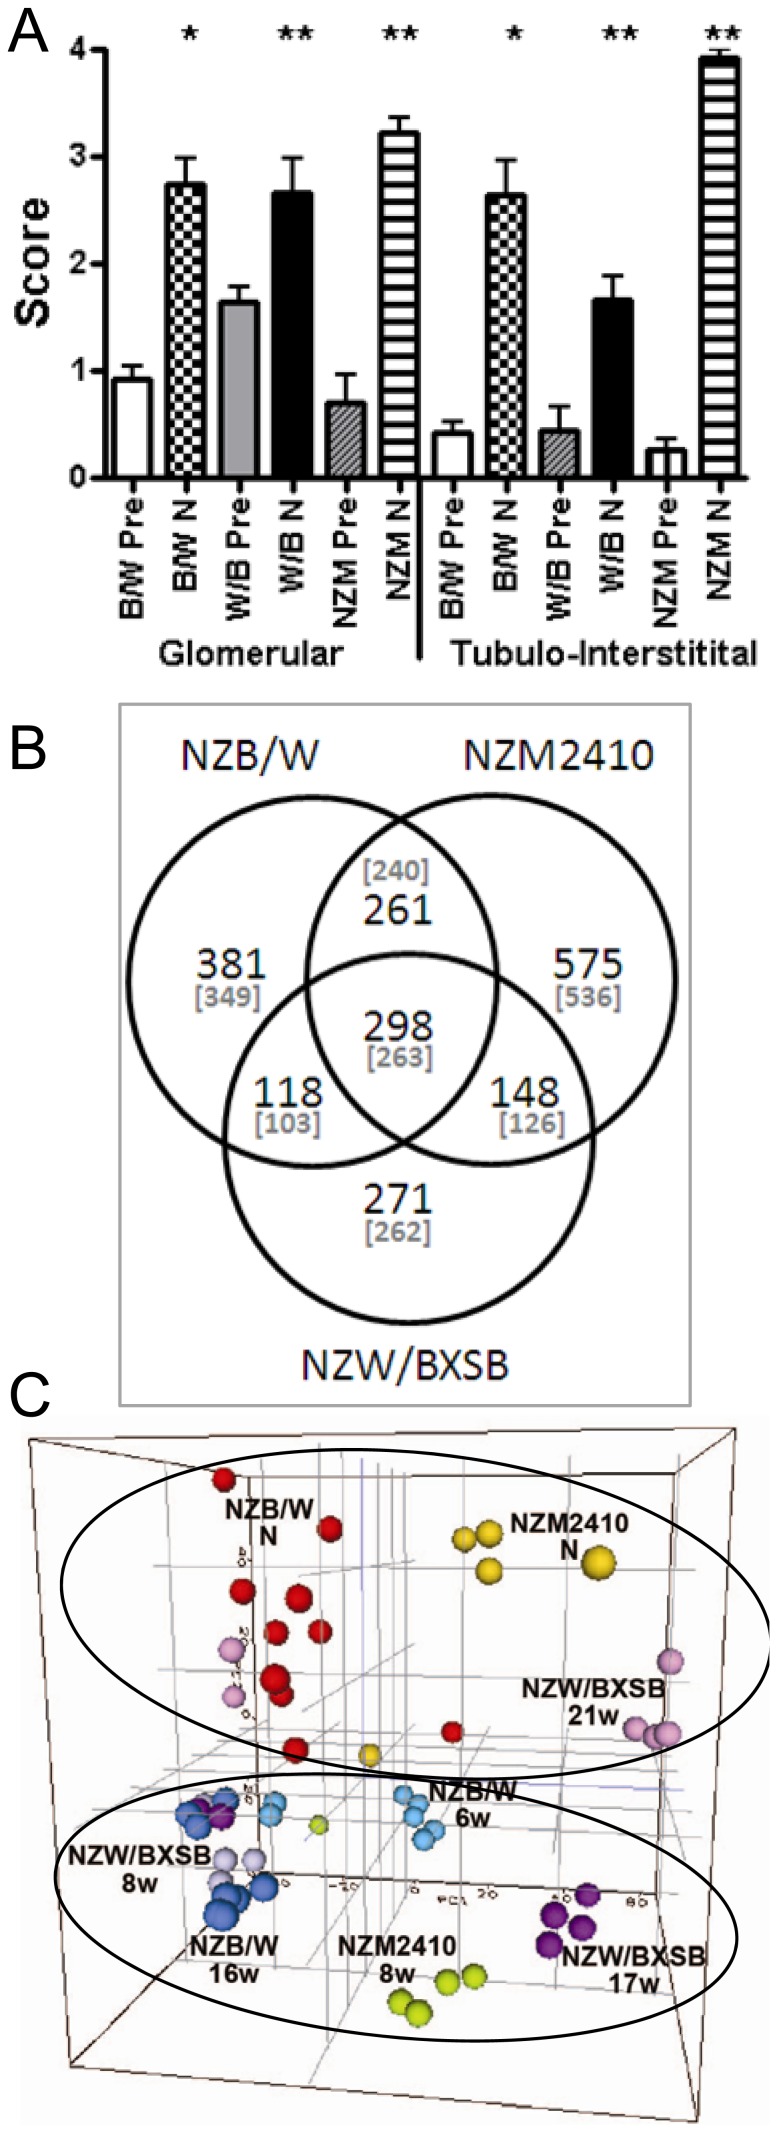
A. Glomerular and interstitial damage scores in pre-nephritic (Pre) and nephritic (N) mice (mean + SD) of NZB/W (B/W), NZW/BXSB (W/B) and NZM2410 NZM) strains (* p<0.001; ** p<0.01). The high tubulointerstitial score in the NZM2410 strain reflects severe tubular atrophy. B. Shared and unique gene expression profiles of each of the three strains. Parentheses indicate the number of genes with a human ortholog. C. 3D principal component analysis from the 14780 genes passing the cutoff value (see Materials and Methods) after normalization and batch correction of the arrays from the 3 mouse strains together.